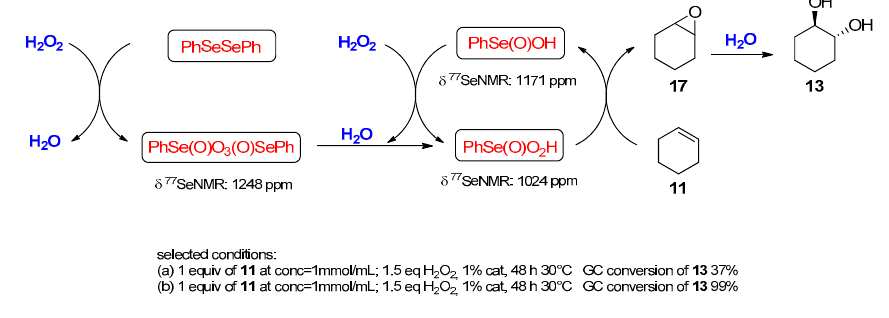
Figure 13. Oxidation of olefins mediated by PhSeO 3 H.